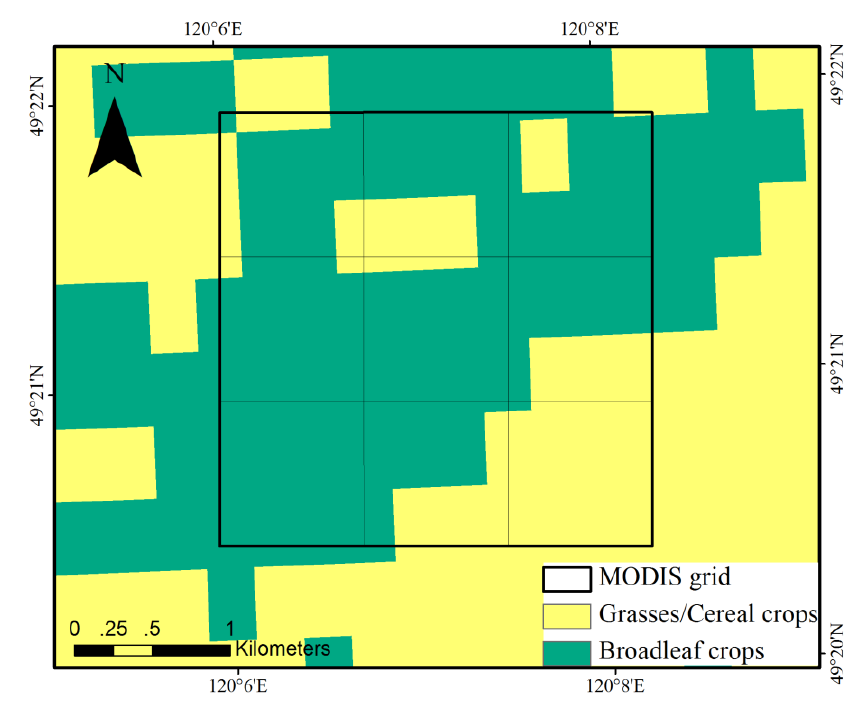
Figure 7. The land cover map of the study